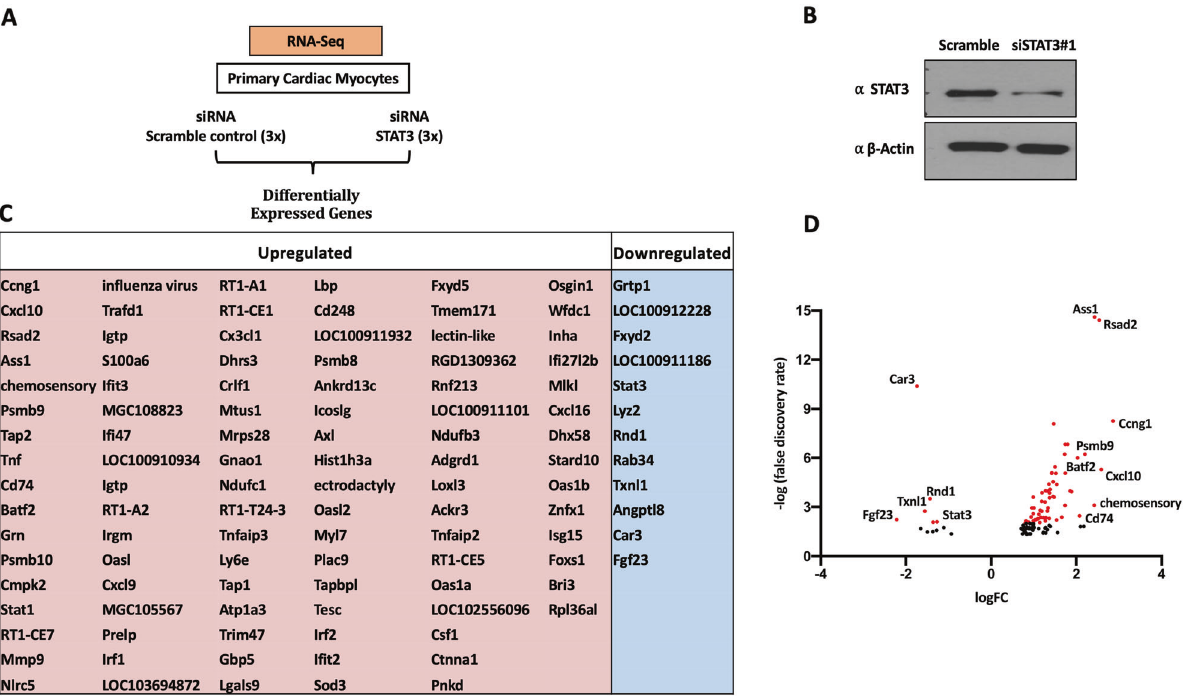
Fig. 5 Identi fi cation of differential expressed genes in STAT3 knock down in PCMs. A Work fl ow of RNA sequencing in PCMs. PCMs were transiently transfected by siRNA targeting STAT3 (siSTAT3#1) to deplete the endogenous STAT3 level or a scrambled siRNA used as controls at 48 h. RNAs were extracted for next gen-sequencing. B PCMs were transiently transfected with siSTAT3#1 or scrambled siRNA as control. Lysates were collecting at 48 h. Equal amounts of proteins were assessed by western blotting analysis to con fi rm siRNA mediated STAT3 depletion as compared to scrambled controls. Data are representative of n = 3 biological replicates. C Genes identi fi ed by RNA-seq analysis that are upregulated (Red) or downregulated (Blue) in STAT3 depleted PCMs (FDR < 0.05). D A volcano plot indicates upregulated and downregulated genes in siSTAT3 RNA-seq data. Black data point if FDR value >0.01. Red data points if FDR value < 0.01. Labels of the genes are shown if − 1.35 > logFC > 2 and FDR value